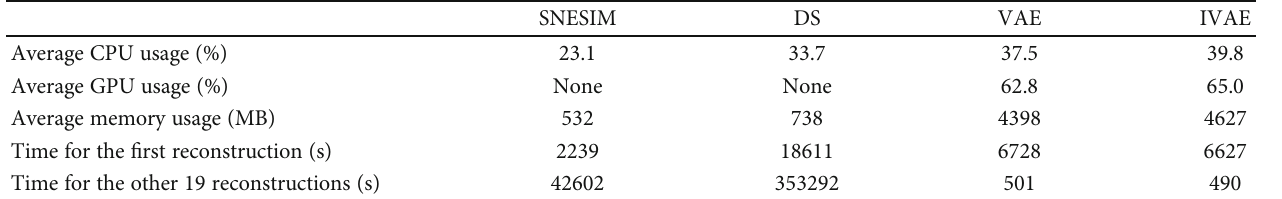
Table 7: The time consumption and average usage of CPU, GPU, and memory by IVAE, SNESIM, VAE, and DS for 20